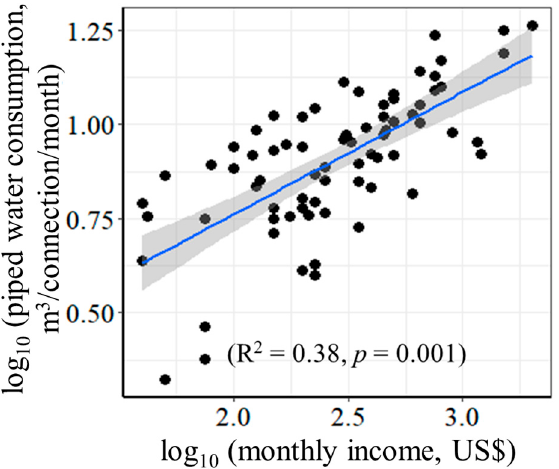
Figure 6. Log correlation between piped water consumption per connection and monthly income of households ( n = 75).